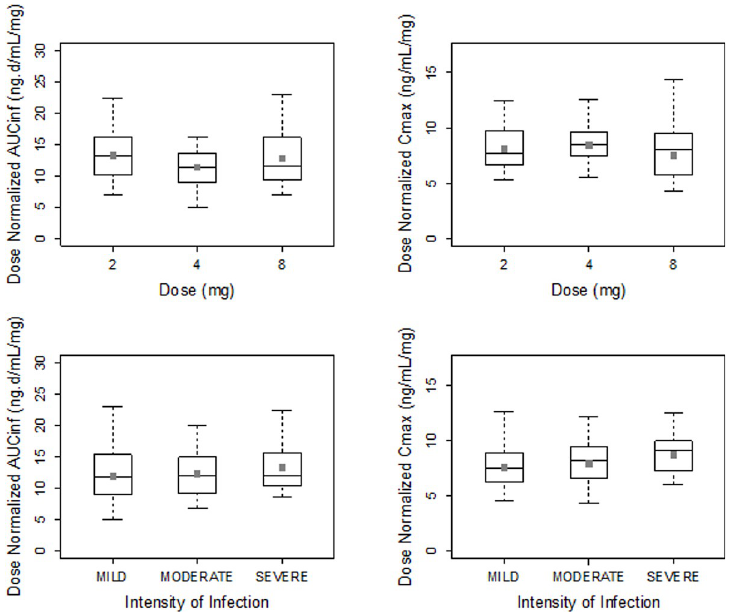
Fig 5. Dose normalized plasma moxidectin exposures by dose and severity of infection. Box plot provides median and 25%/75% quartiles with whiskers to the last point within 1.5 times interquartile range. Solid squares represent geometric mean.